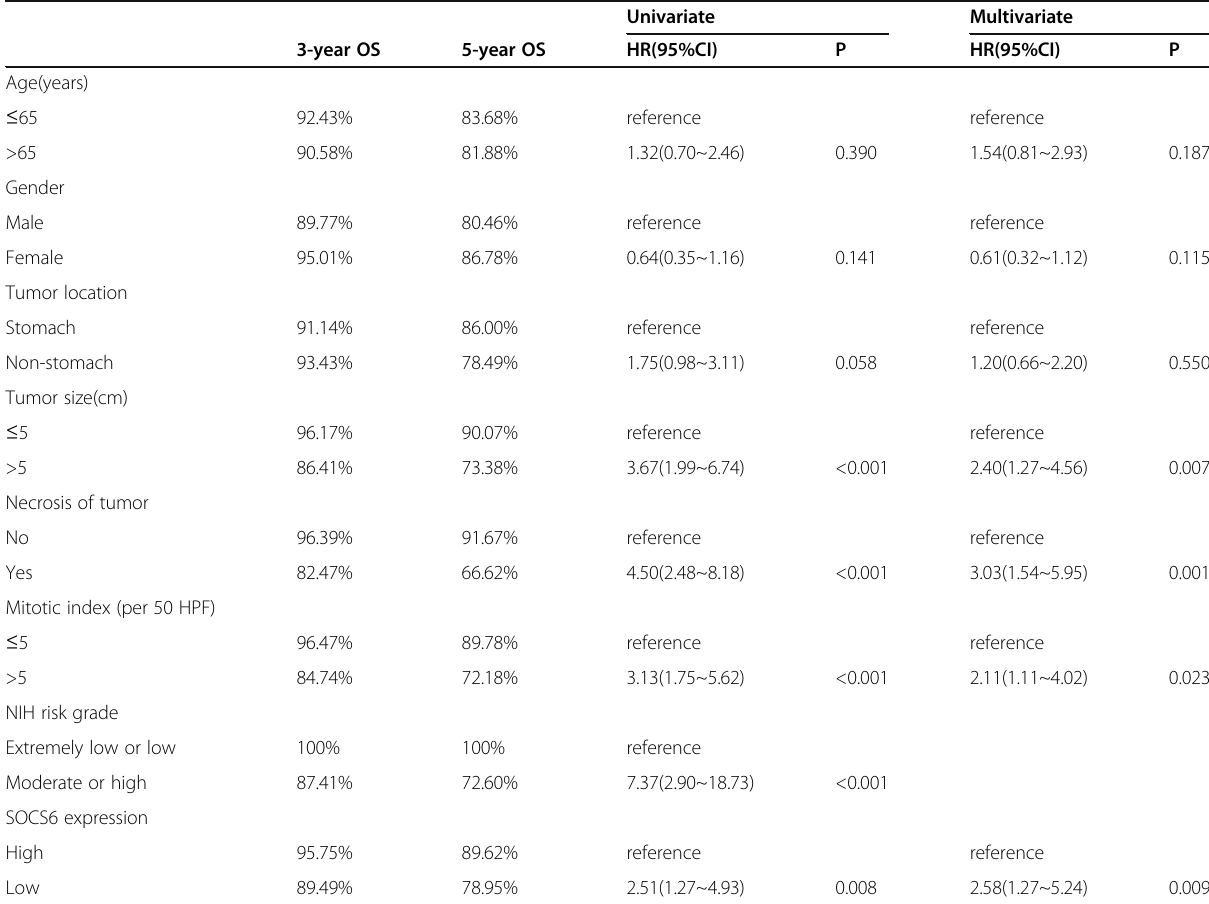
Table 2 Cox proportional-hazard regression model analysis for overall